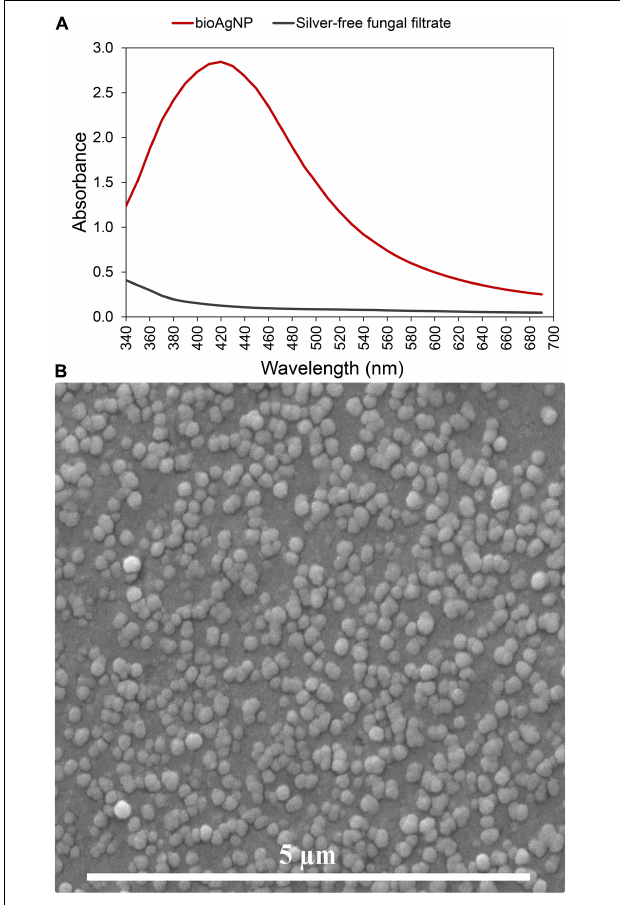
FIGURE 1 | Characterization of the biogenically synthesized silver nanoparticles (bioAgNP) regarding their plasmonic band and